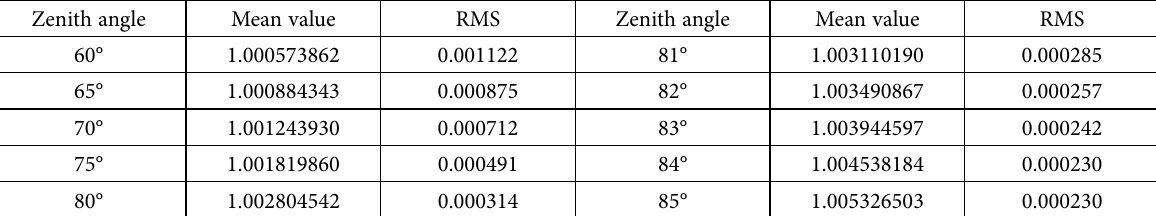
Table 3. Mean values of the factor K for Egypt at different elevation angles Zenith angle